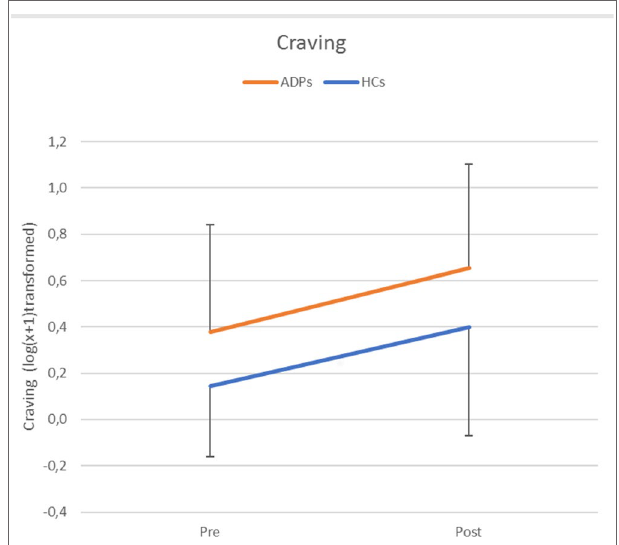
FIGURE 2 | Craving levels per group and time point [pre/post-emotion reappraisal task (ERT)]. Error bars reflect standard deviations. Craving levels were log( x + 1) transformed and refer to self-reported Alcohol Urge Questionnaire (AUQ)